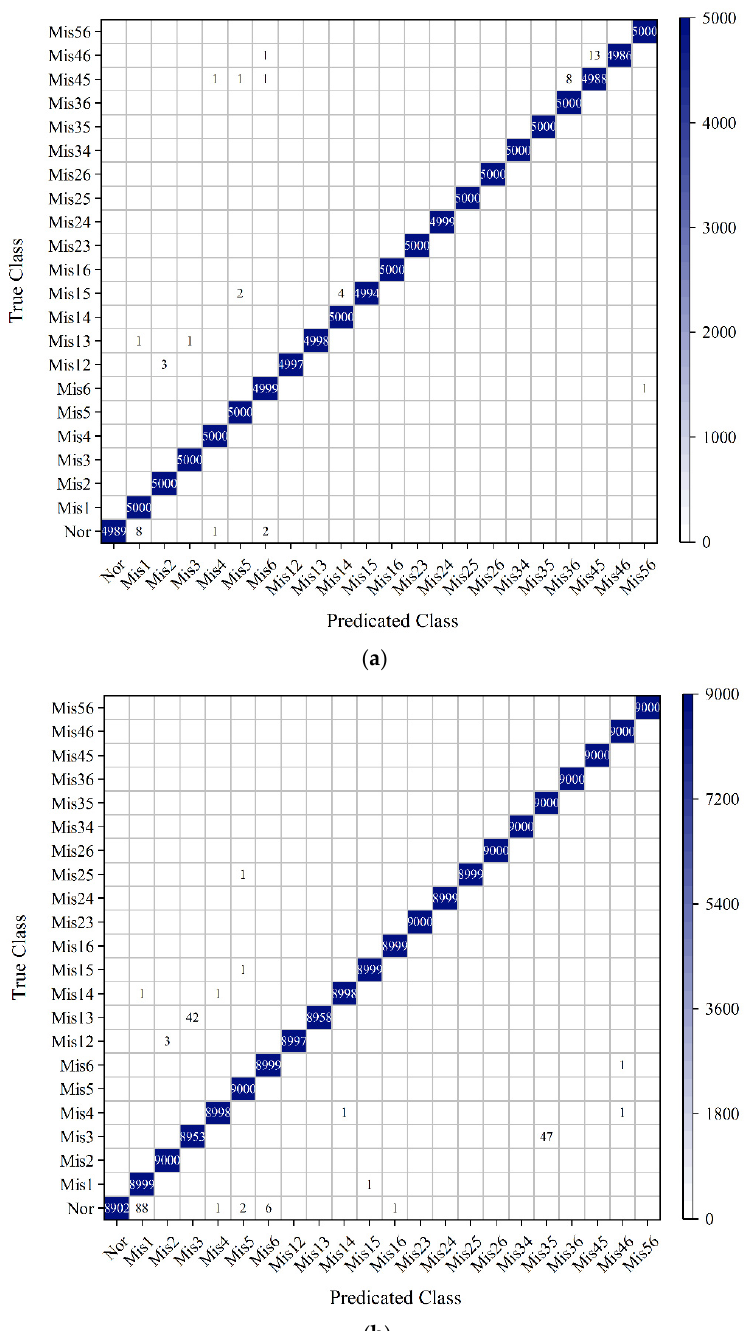
Figure 19. Confusion matrices of the results acquired with the third network and data division mode 2_b. ( a ) Training result. Total accuracy is 99.95%. ( b ) Testing result. Total accuracy is